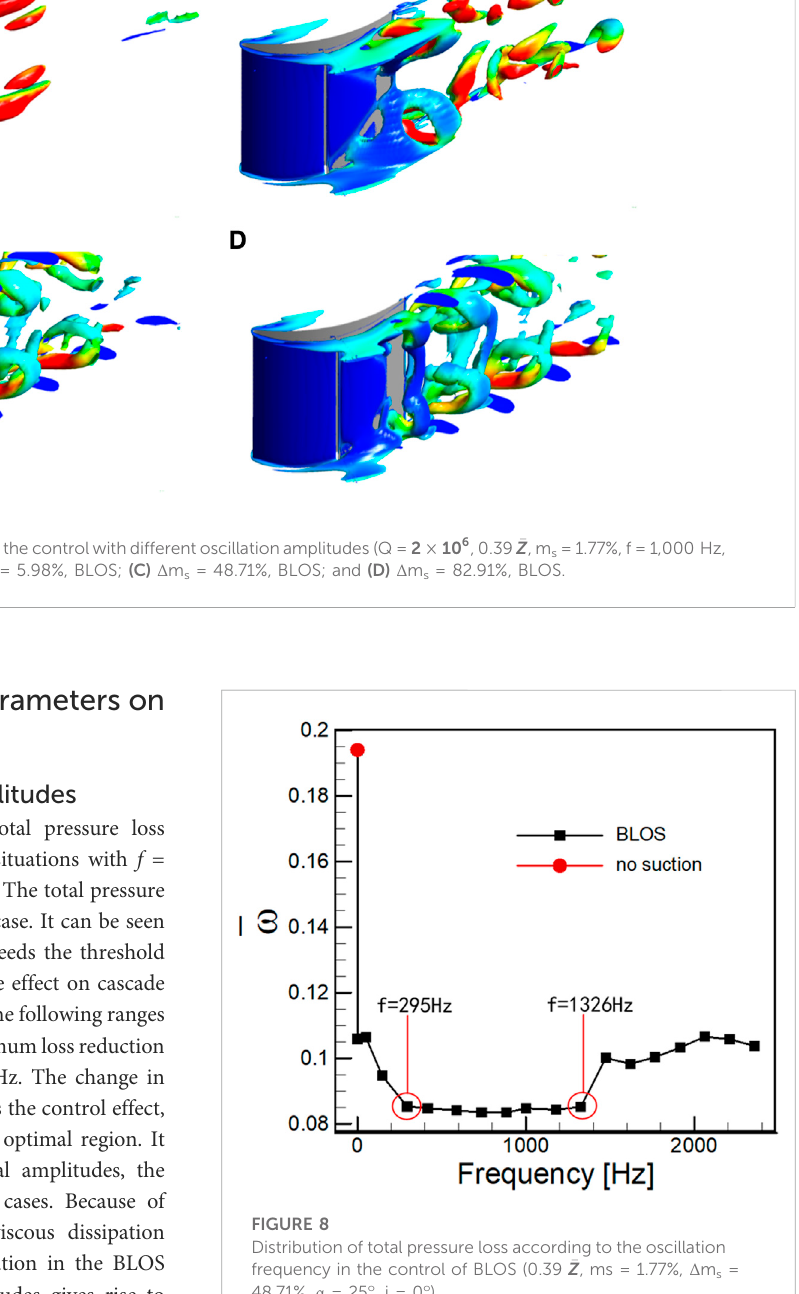
FIGURE 8 Distribution of total pressure loss according to the oscillation frequency in the control of BLOS (0.39 (cid:1) Z , ms = 1.77%, Δ m s = 48.71%, α = 25 o , i = 0 o